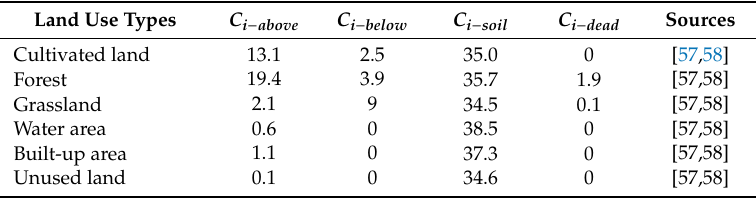
Table 2. Mean carbon densities for each land-use type in the Su-Xi-Chang region (Mg C /